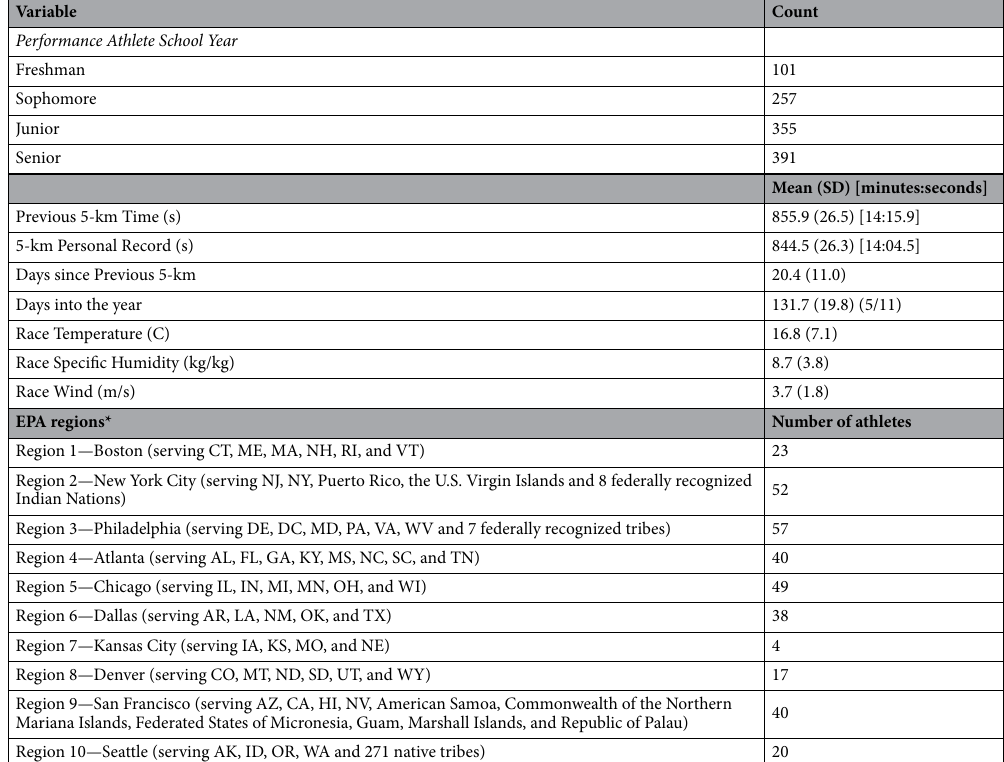
Table 1. Descriptive statistics. *6 athletes transferred to another region within study